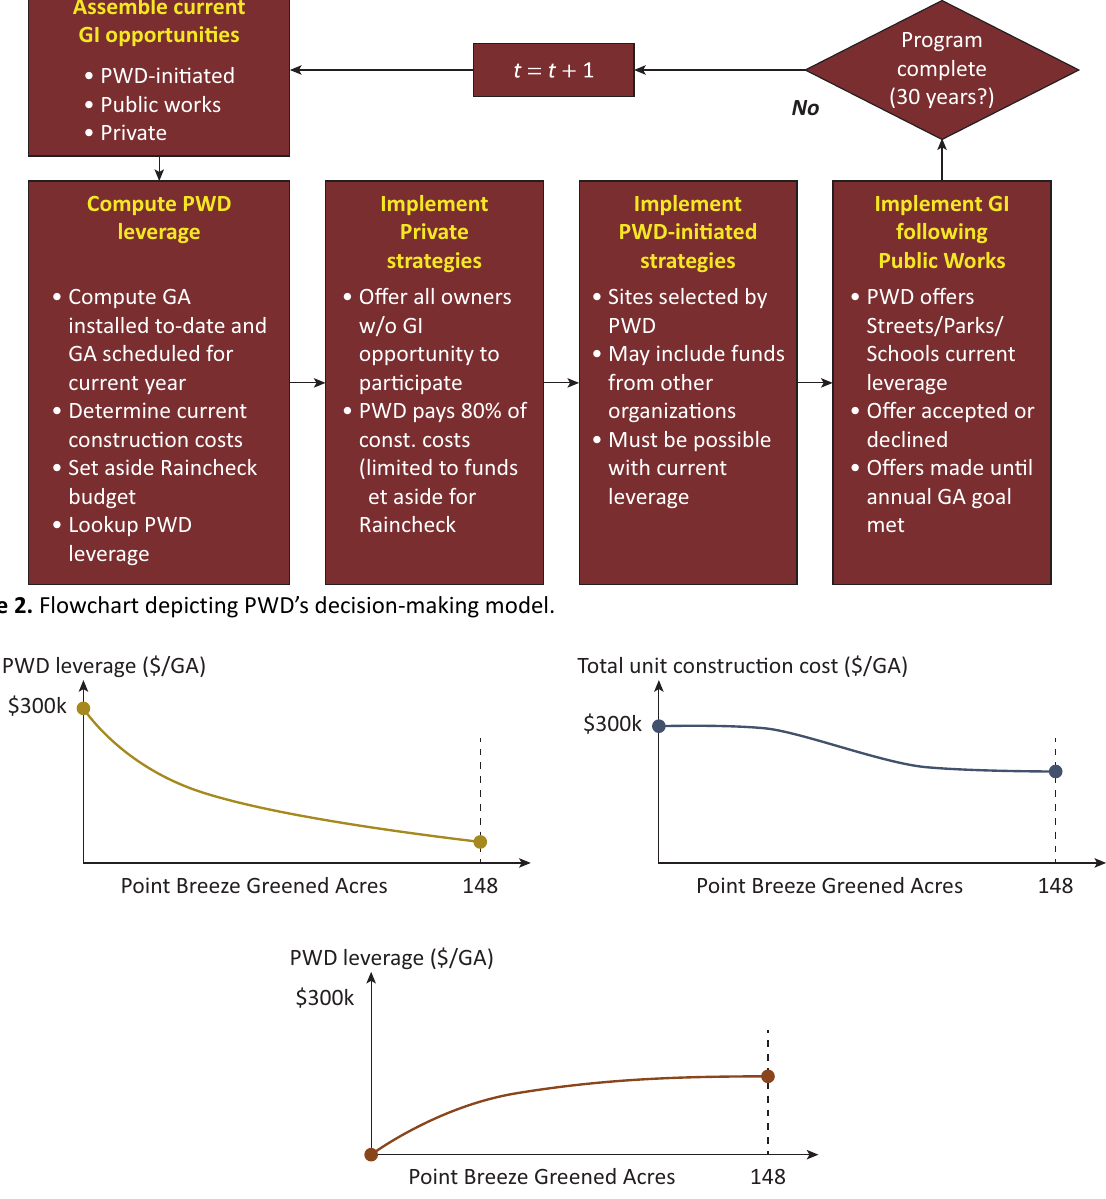
Figure 3. Calculation of PWD’s leverage